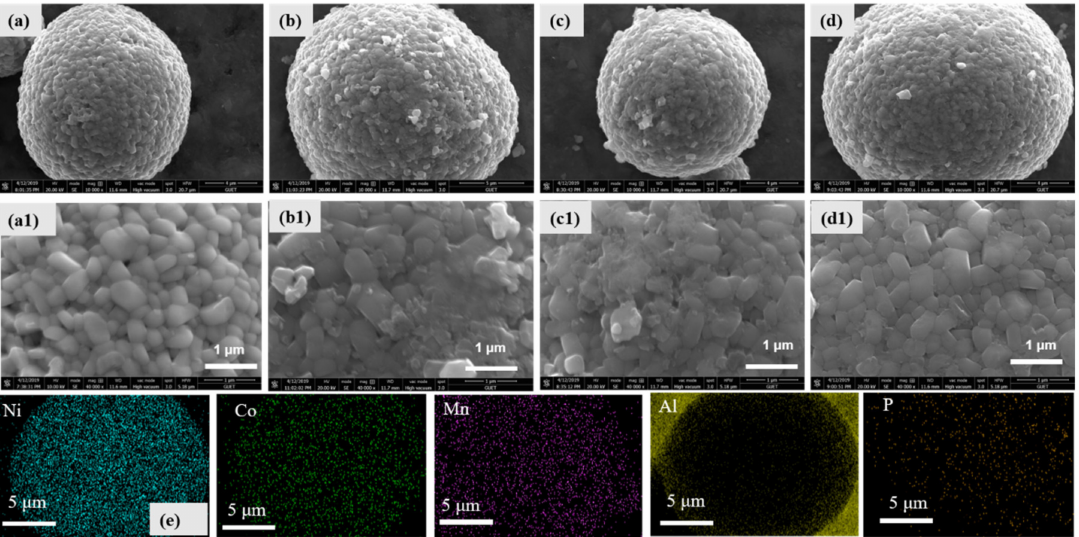
Figure 2. SEM images of NCM811 and Al(PO 3 ) 3 -modified NCM811 materials, ( a ) bare NCM811, ( b ) NCM811@ALP400, ( c ) NCM811@ALP500, ( d ) NCM811@ALP600, ( a1 – d1 ) the magnified images of ( a – d ), ( e ) EDS mappings of